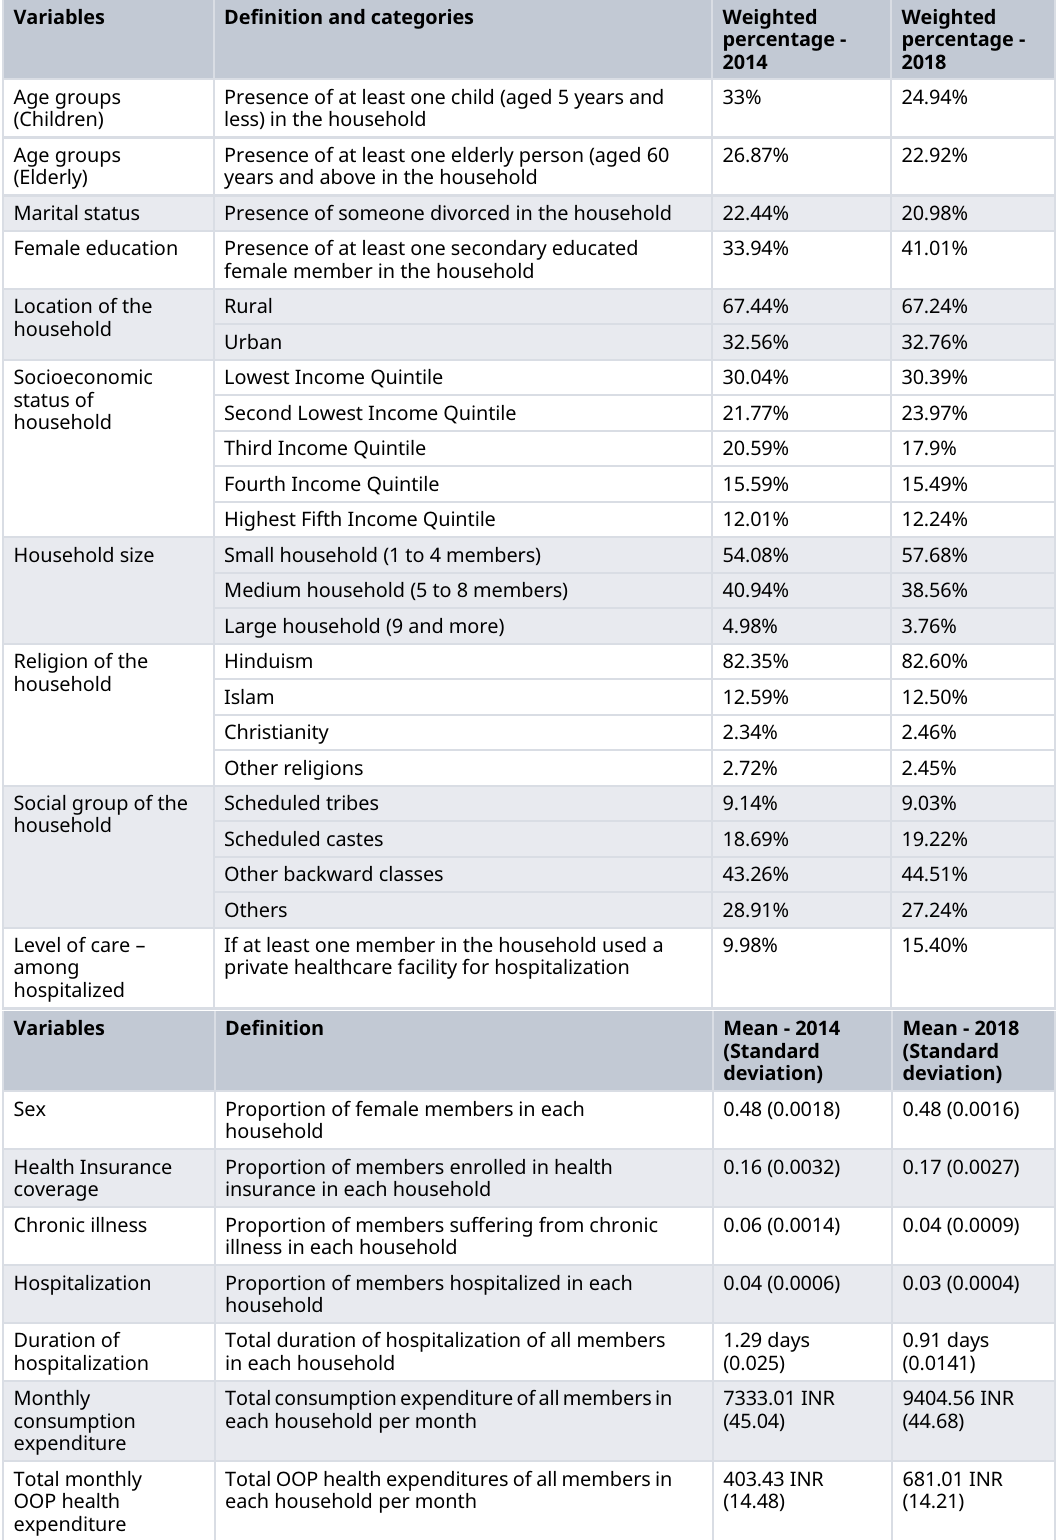
Table 1. Descriptive statistics of the household